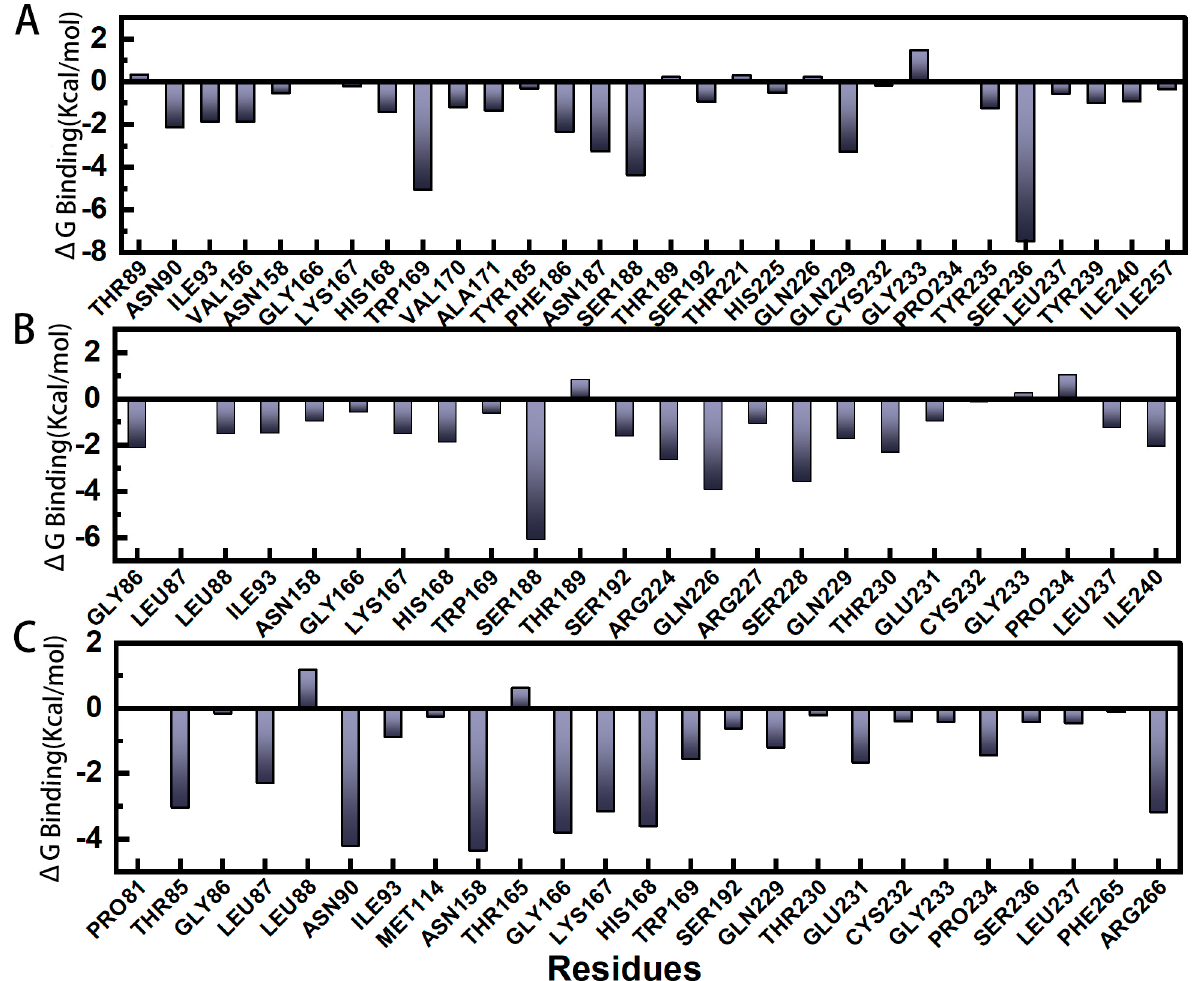
Figure 7. The Gibbs binding free energy decomposition diagram of pS273R − E64 complex based on (MM − PBSA). ( A – C ) are trajectory 1, trajectory 2 and trajectory 3, respectively.